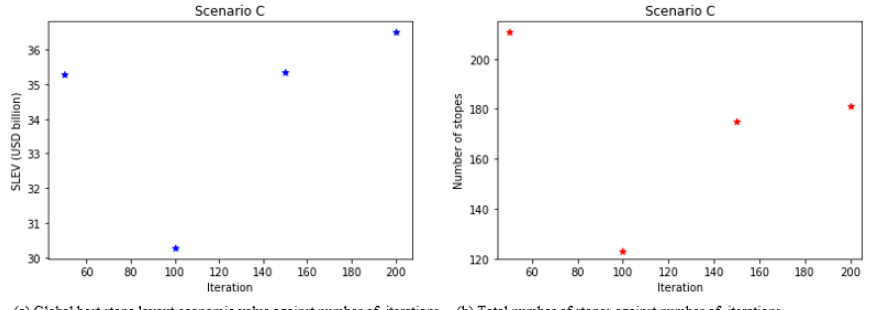
Figure 11. Scenario C: optimisation results of SLEV and number of stopes.